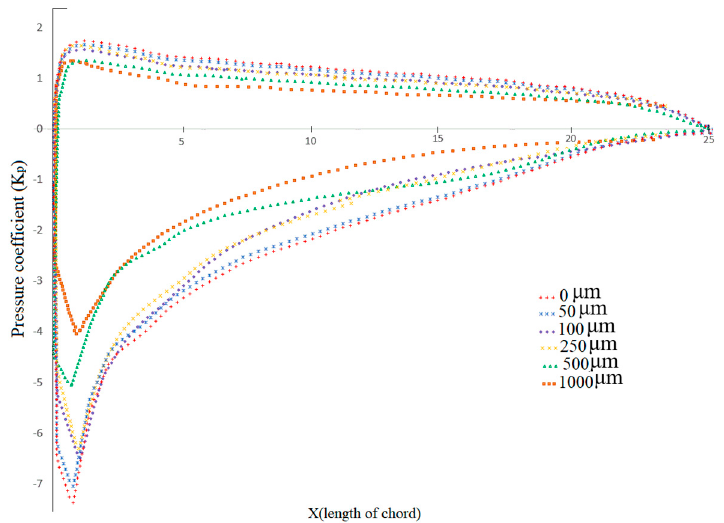
Figure 11. Pressure coefficient ( Kp ) curves on a single NACA 0015 blade at different roughness heights.